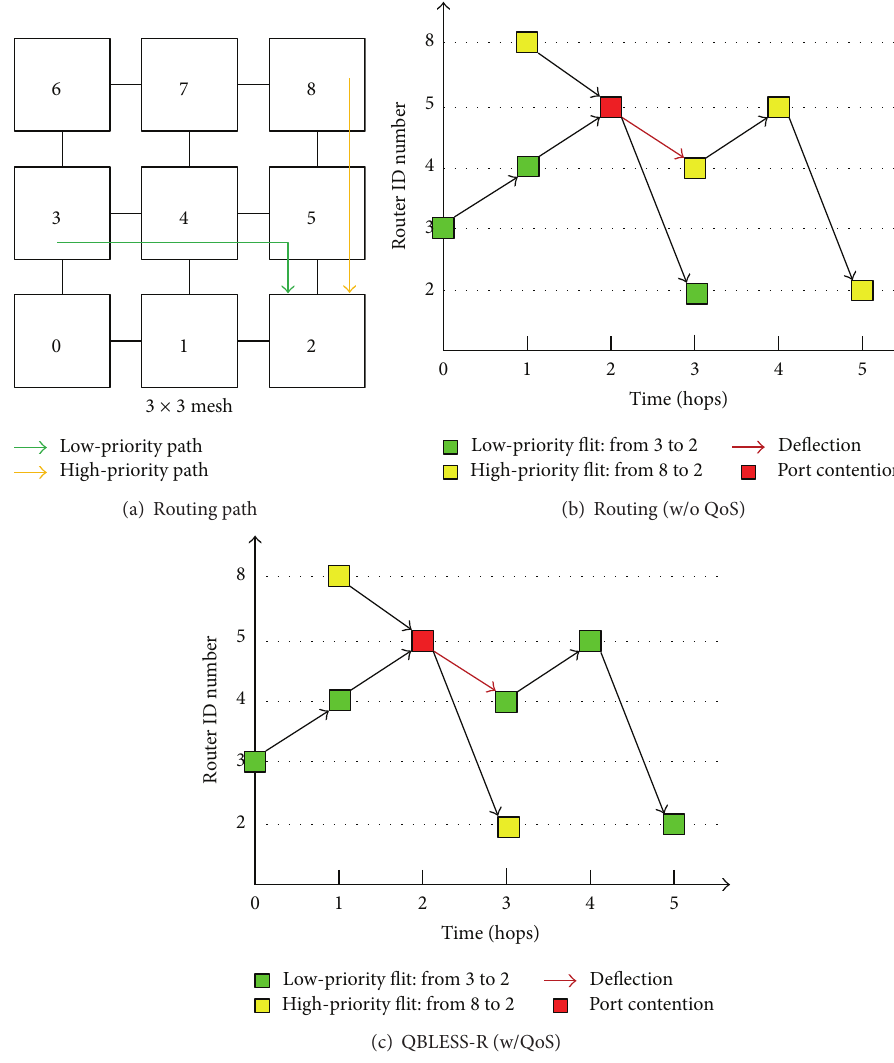
Figure 4: Example of